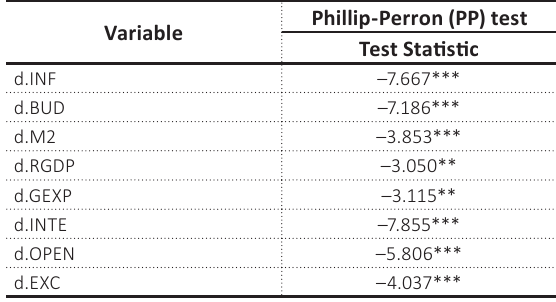
Table 2. Stationarity of the variables